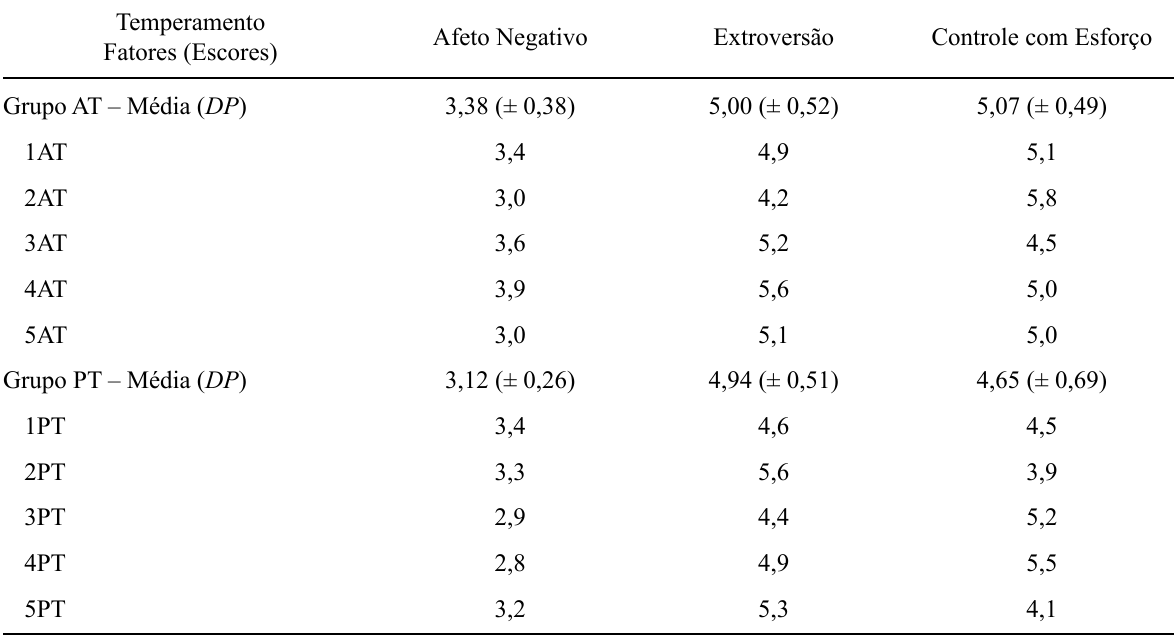
Indicadores do Temperamento das Crianças (Fatores) Avaliados pelo ECBQ, na Faixa de 18 a 36 Meses de Idade, no Grupo de Crianças Nascidas A Termo (Grupo AT) e Pré-Termo (Grupo PT)